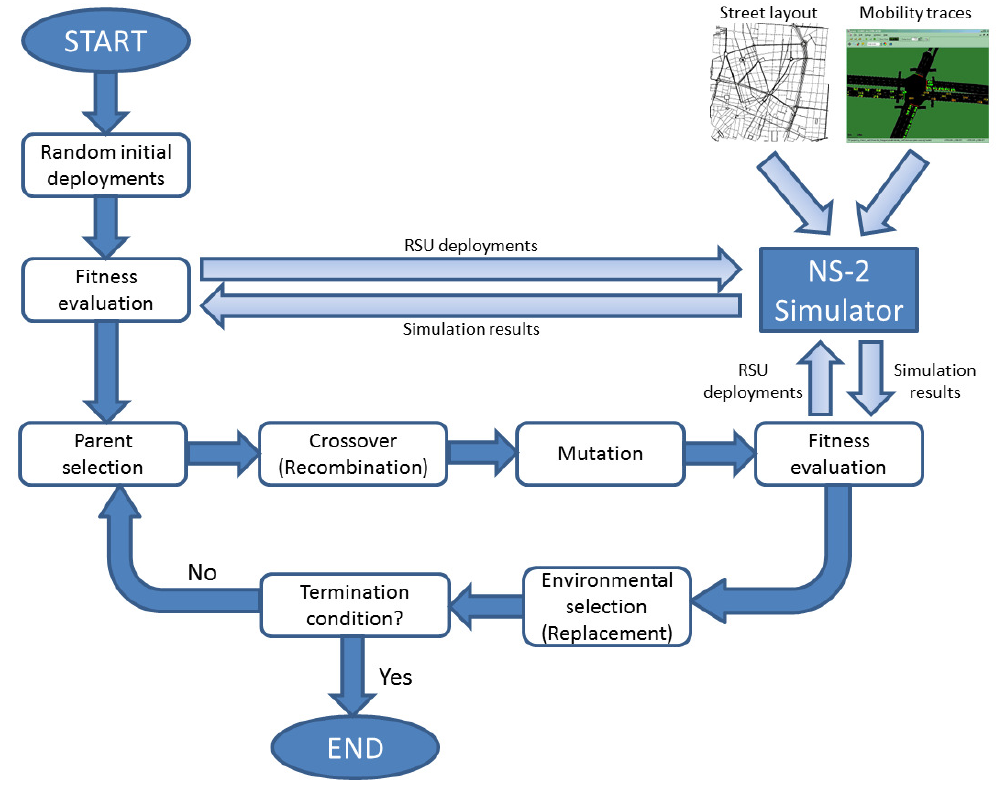
Figure 3. GARSUD